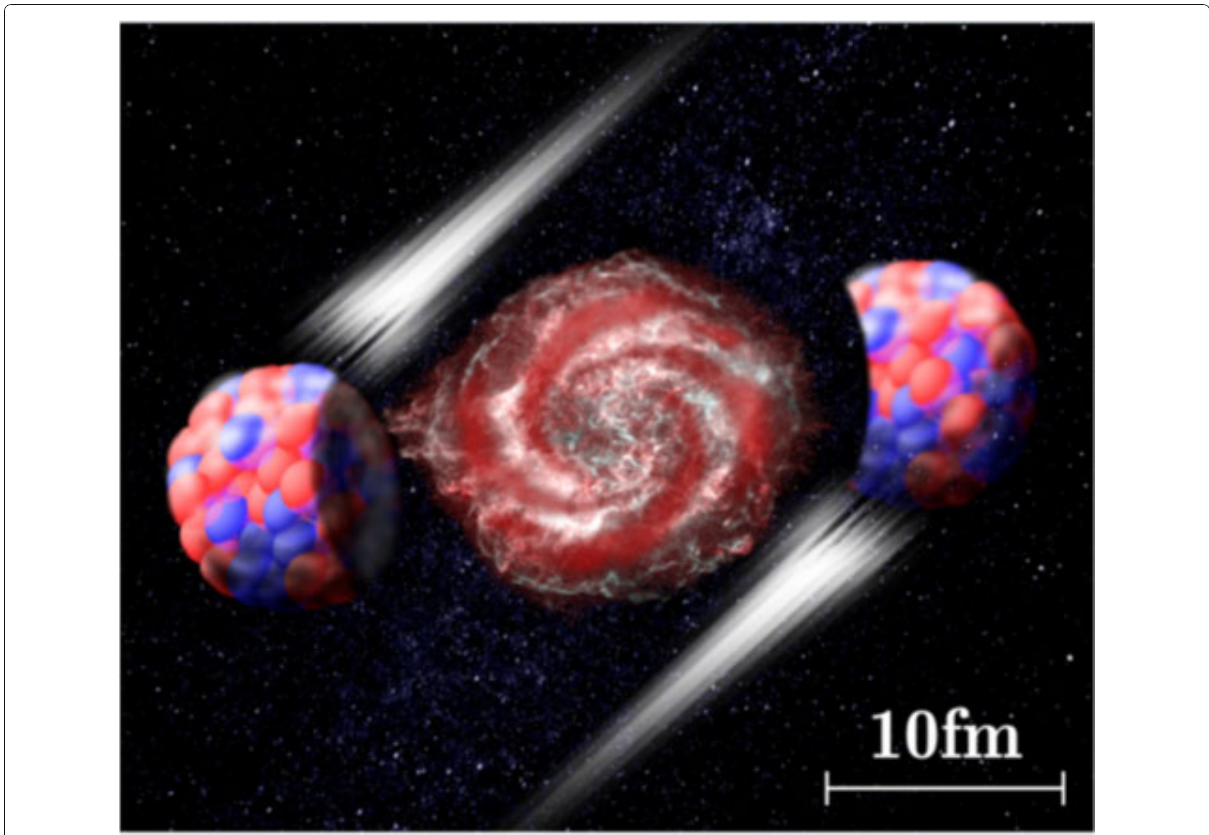
Fig. 1 Schematic illustration of a femto-nova as a femtometer-scale explosion of baryon-rich matter in relativistic heavy-ion